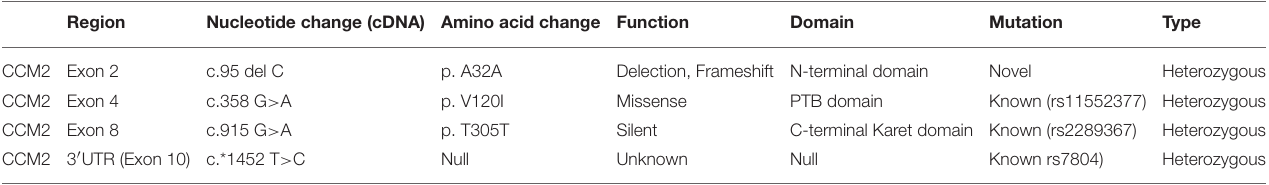
TABLE 1 | Mutations identified in siblings with CCMs (II-1 and